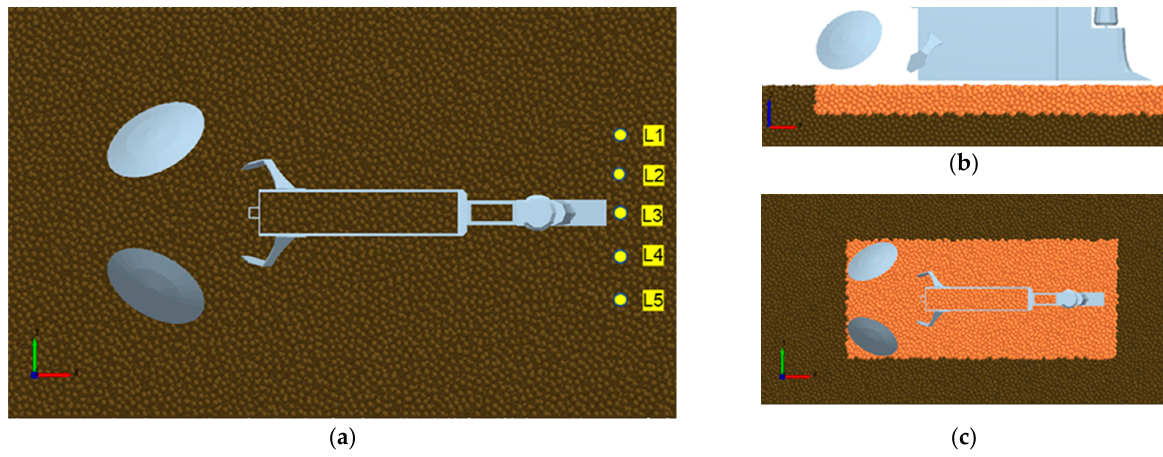
Figure 11. Particle distribution of soil: ( a ) Schematic diagram of soil particle distribution, L1–L5 were soil particles selected in sequence.; ( b ) Cross ‐ sectional view of the soil covering a range of the soil ‐ covering device; ( c ) Top view of the soil covering a range of the soil ‐ covering device.